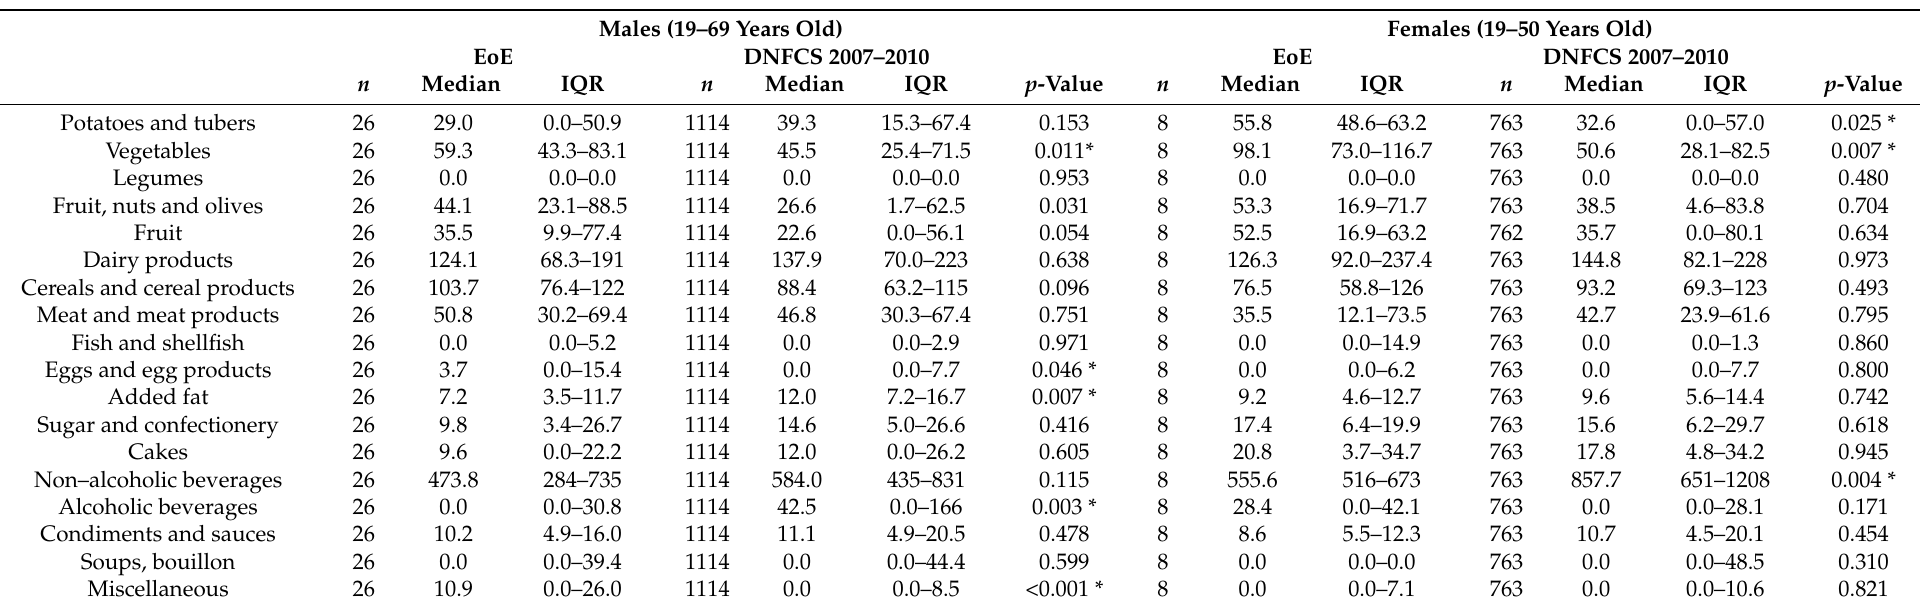
Table 5. Comparison of the intake of different food groups (in grams per 1000 kcal) between EoE patients and the general Dutch